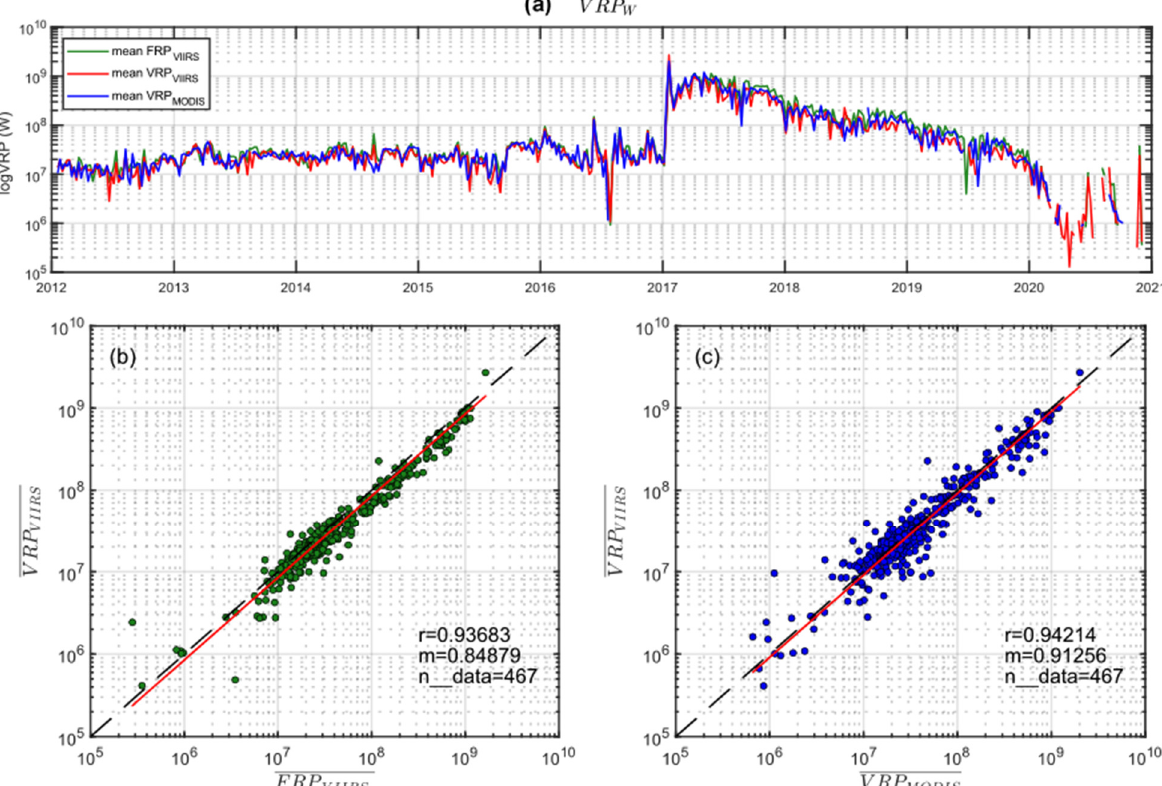
Figure 9. ( a ) Stacked time series of VRPw retrieved for MIROVA VIIRS (red), MIROVA MODIS (blue), and FIRMS VIIRS (green) at Erta Ale volcano in logarithmic scale. ( b , c ) Linear regression analyses between VRP VIIRS and FRP VIIRS -derived VRPw (green), and VRP VIIRS and VRP MODIS -derived VRPw (blue) at Erta Ale, respectively. The best-fit coefficients m close to 0.9 and the Pearson correlation coefficients r ~0.94 indicate an excellent correlation between the time series retrieved by MIROVA and FIRMS algorithms.